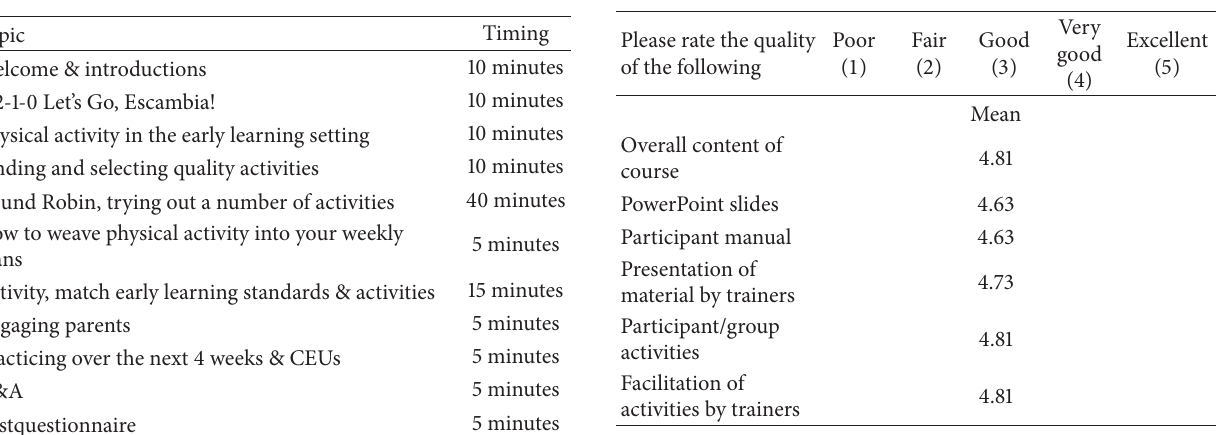
Table 3: Final training workshop topics. Table 4: Overall course